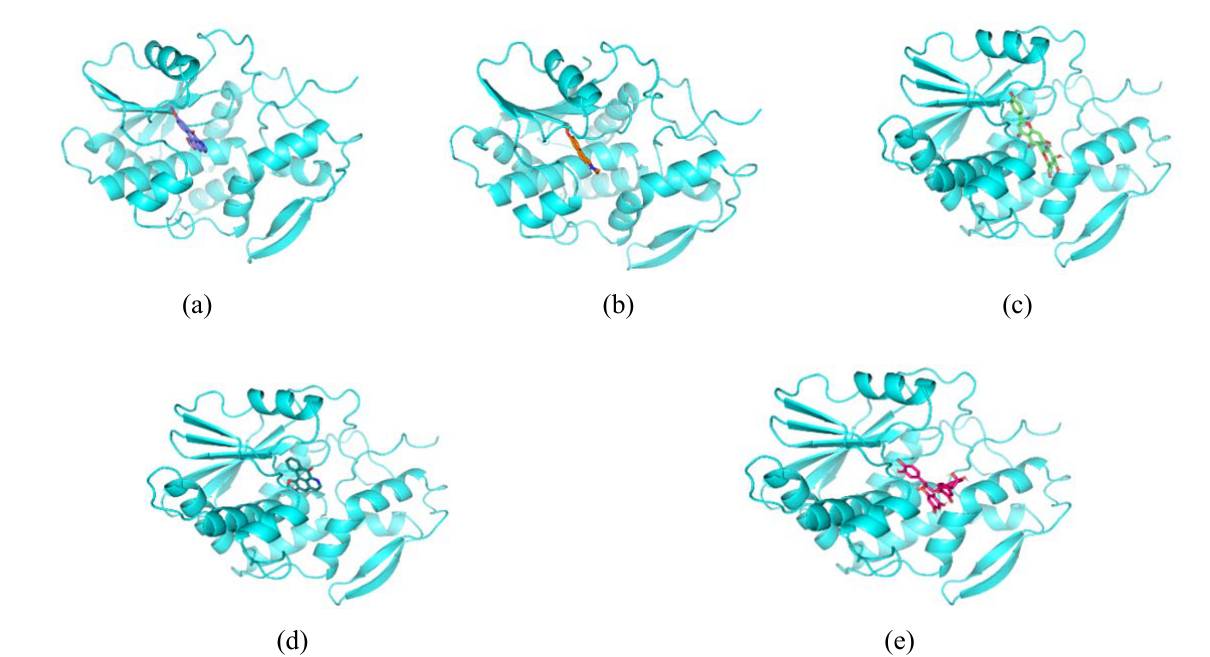
Figure 3. 3D visualization in PyMOL 2.5 (by Schrödinger) to show the interaction between ricin and (a) lanuginosine; (b) xylopine; (c) isovitexin; (d) liriodenine; and (e) procyanidine, as virtual screening result using AutoDock